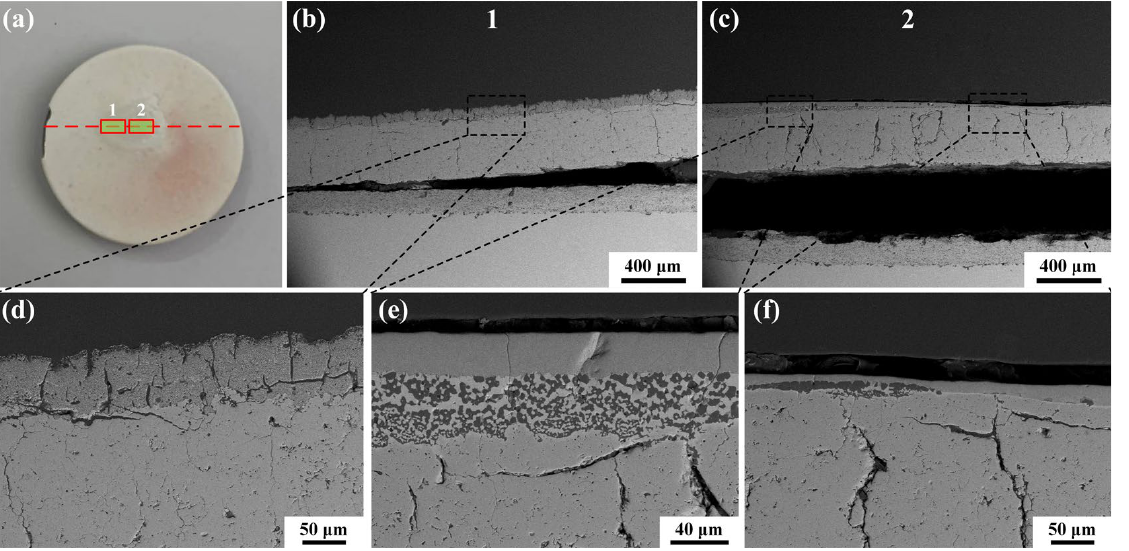
Figure 7. ( a ) Macroscopic and ( b – f ) cross-sectional morphologies of AGAP-YSZ coating after thermal shock test.